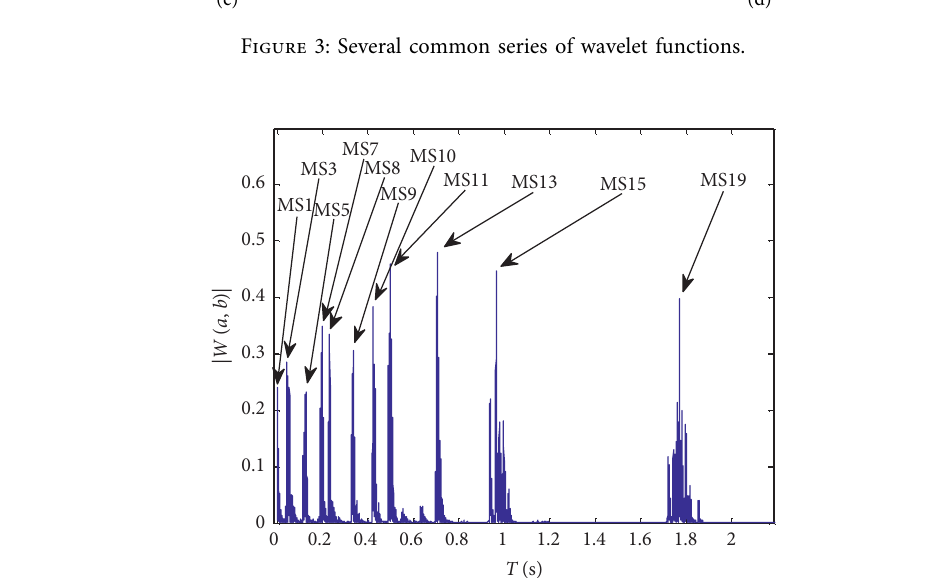
Figure 4: Modulus value map by db8 continuous wavelet transform ( a �